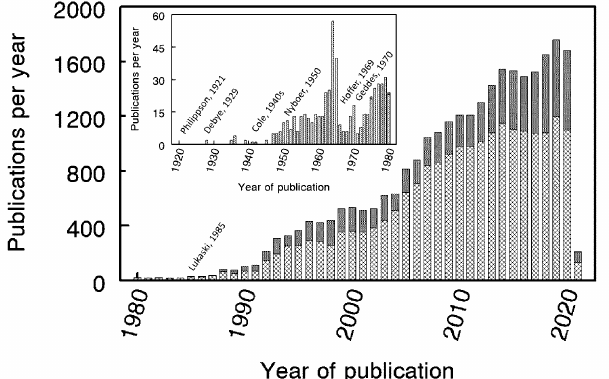
Fig 1: Publications per year in the field of electrical bioimpedance listed on PubMed. "Search query: (""Bioimpedance"" OR ""bioelectrical impedance"" OR ""electrical impedance"" OR ""electrical